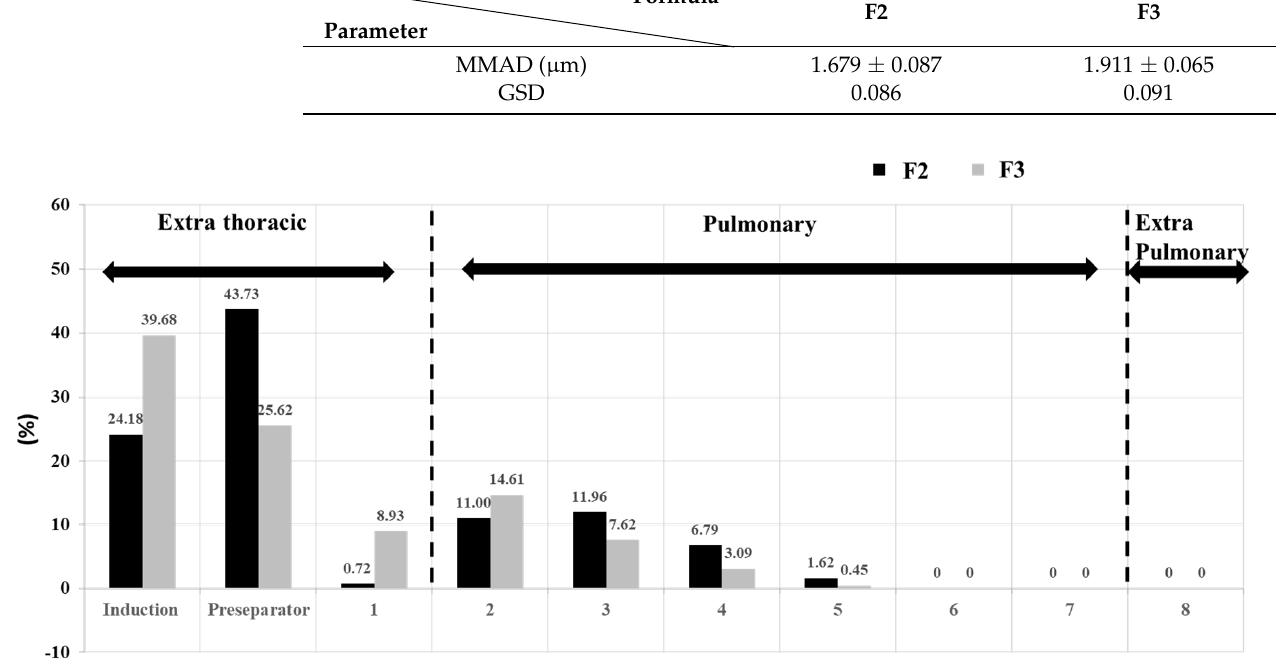
Figure 11. Aerodynamic particle size distribution of TQ-containing nanoparticles, highlighting the percentage of particles deposited the pulmonary section, which is the lower part of the respiratory system. Results are presented as means ± SD, n = 3.